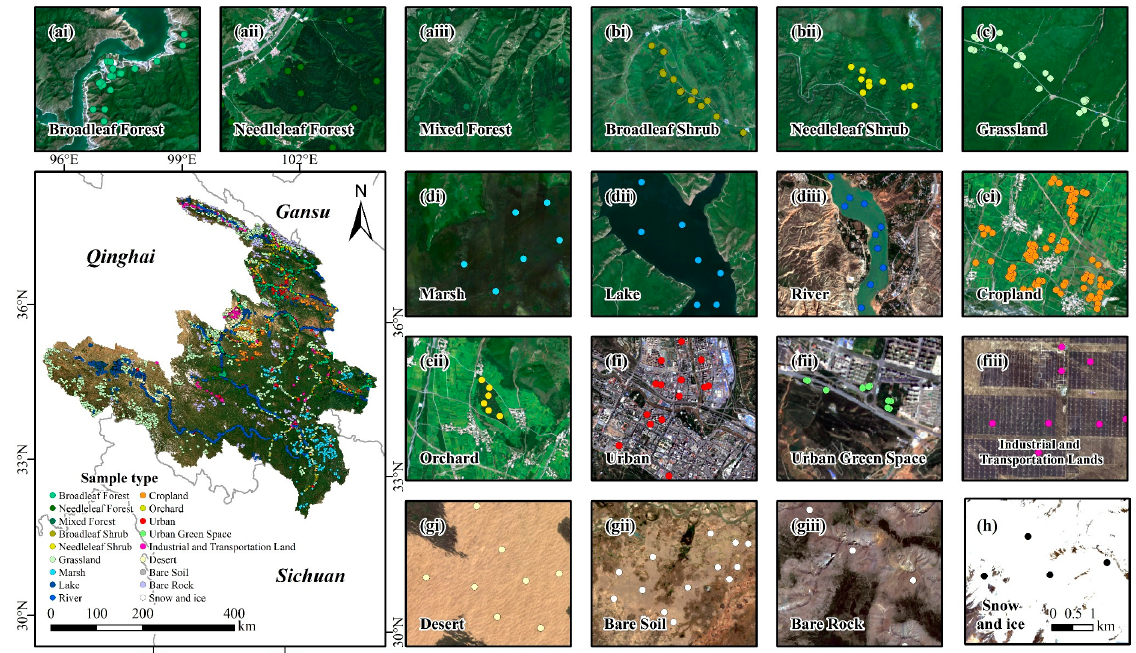
Figure 4. Spatial distribution of LULC second-degree class sample points. ( ai – h ) Sentinel-2 RGB true-color composite image of LULC second-degree class sample points. Table 2. The LULC classification scheme of this study.